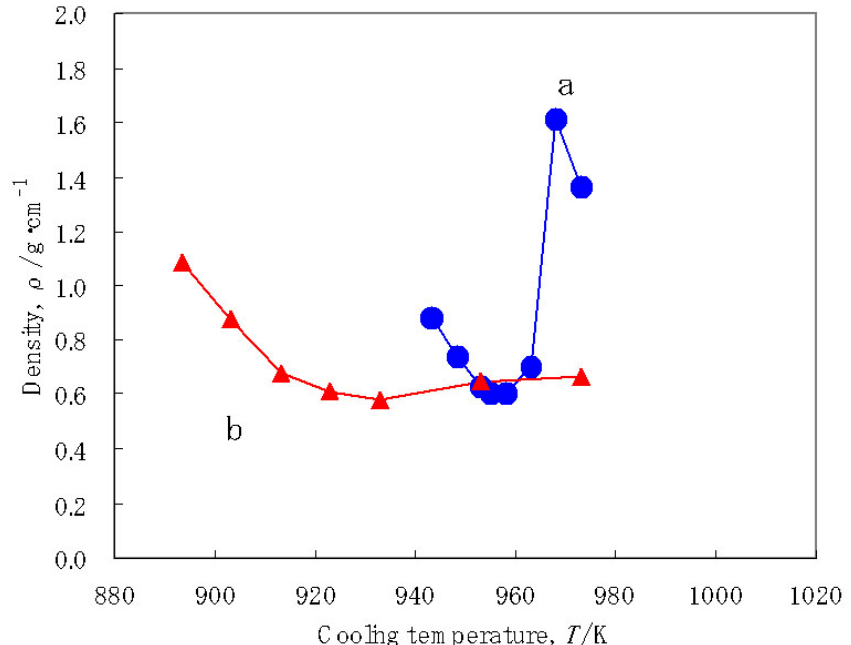
Figure 2. Densities of foams: ( a ) 2.0 mass% dolomite and ( b ) 2.0 mass% dolomite and 1.0 mass% MgCO 3